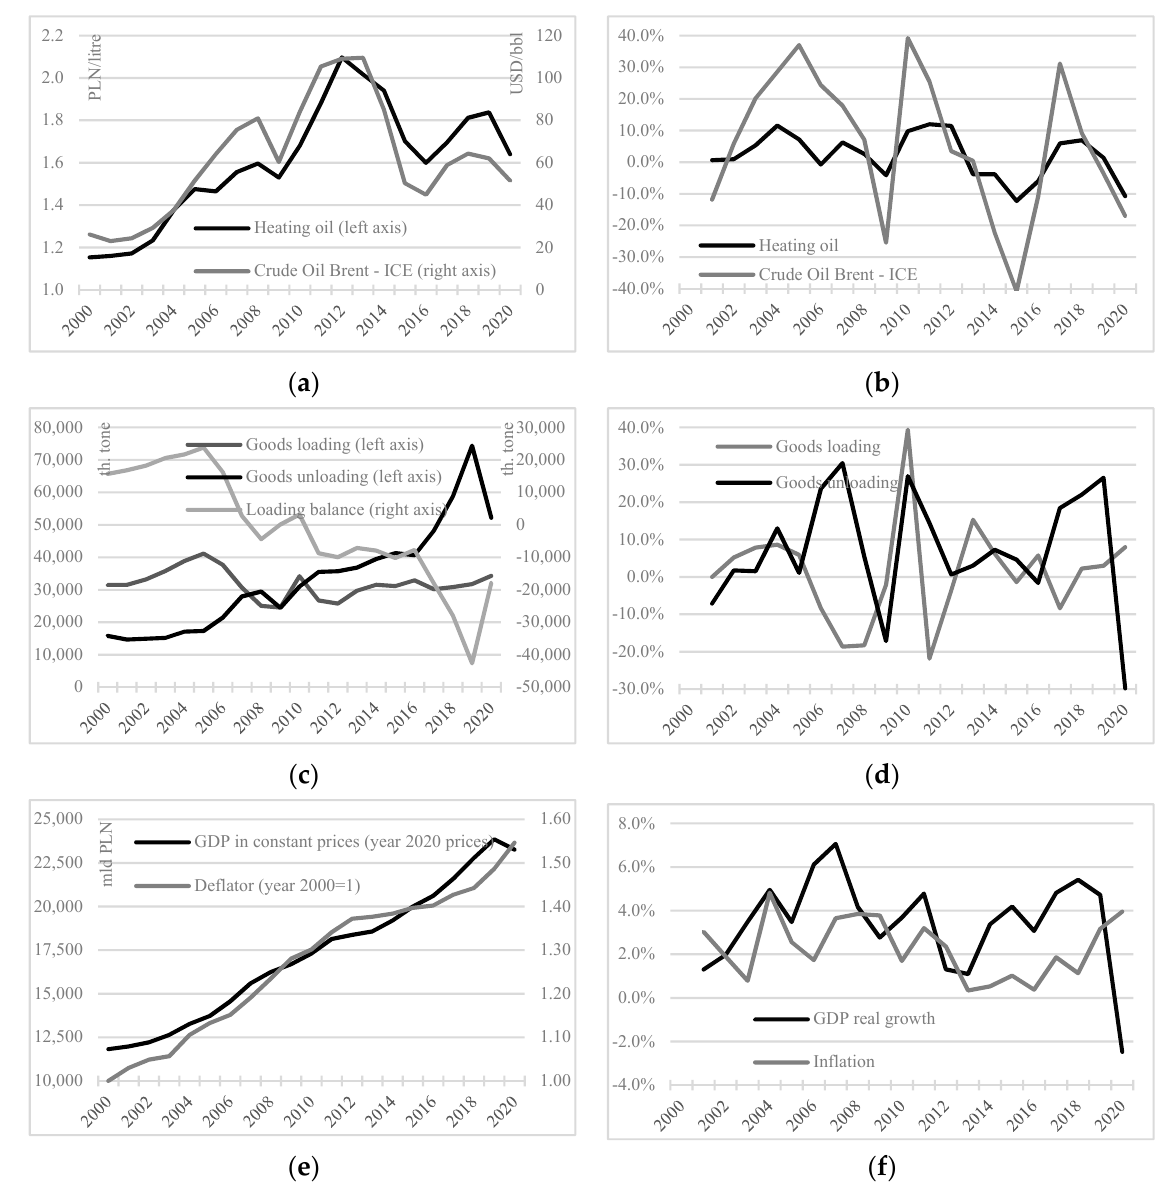
Figure 1. Formation of variables analyzed. ( a ) Heating oil and crude oil prices. ( b ) Fuel price dynamics. ( c ) Transhipments in seaports. ( d ) Dynamics of transhipments in seaports. ( e ) GDP value and deflator. ( f ) GDP dynamics and Y/Y inflation.